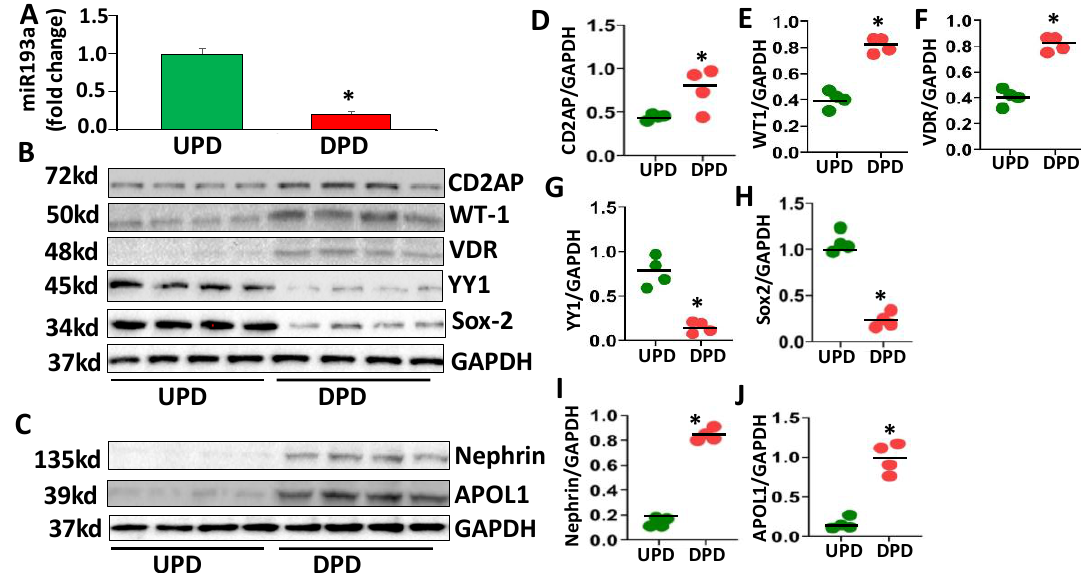
Figure 1. Podocyte molecular profiles in undi ff erentiated (UPD) and di ff erentiated conditions (DPD). Podocytes were incubated in Petri dishes in media either at 33 ◦ C for 48 h (UPD) or at 37 ◦ C for 10 days (DPDs) (n = 4). ( A ) RNAs were extracted and assayed for miR193a (n = 4). Cumulative data are displayed in bar graphs (means ± SD). * p < 0.05 compared with UPD. ( B ) Protein blots from four independent lysates were probed for CD2AP, WT1, VDR, YY1, Sox2, and Glyceraldehyde -3-phosphate dehydrogenase (GAPDH). ( C ) Protein blots from four di ff erent lysates were probed for Nephrin, APOL1, and GAPDH. ( D – J ) Cumulative densitometric data (protein: GAPDH ratio) are shown in dot plots. * p < 0.05 compared with respective UPD.